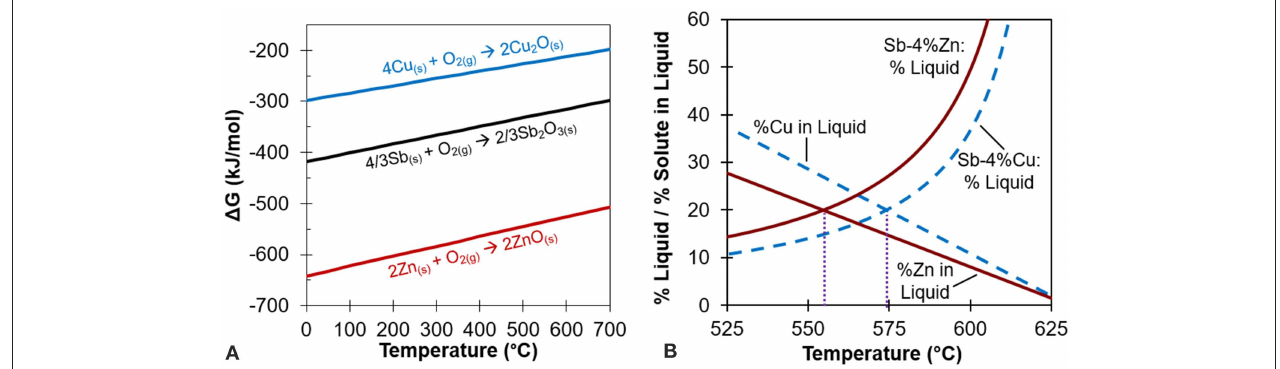
FIGURE 3 | (A) Ellingham diagram of oxides showing Cu, Sb, and Zn. Note how oxide formation of ZnO would preferentially occur over Sb 2 O 3 , but not Cu 2 O over Sb